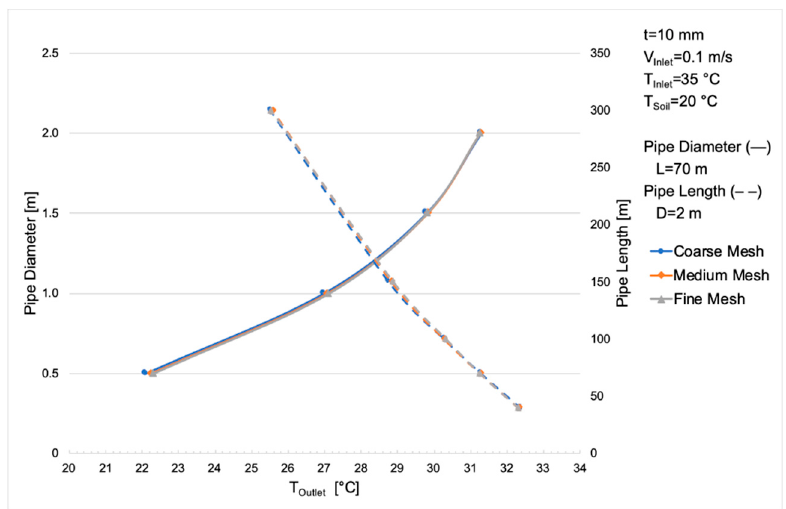
Figure 3. Grid study of the model for different pipe diameters and lengths.